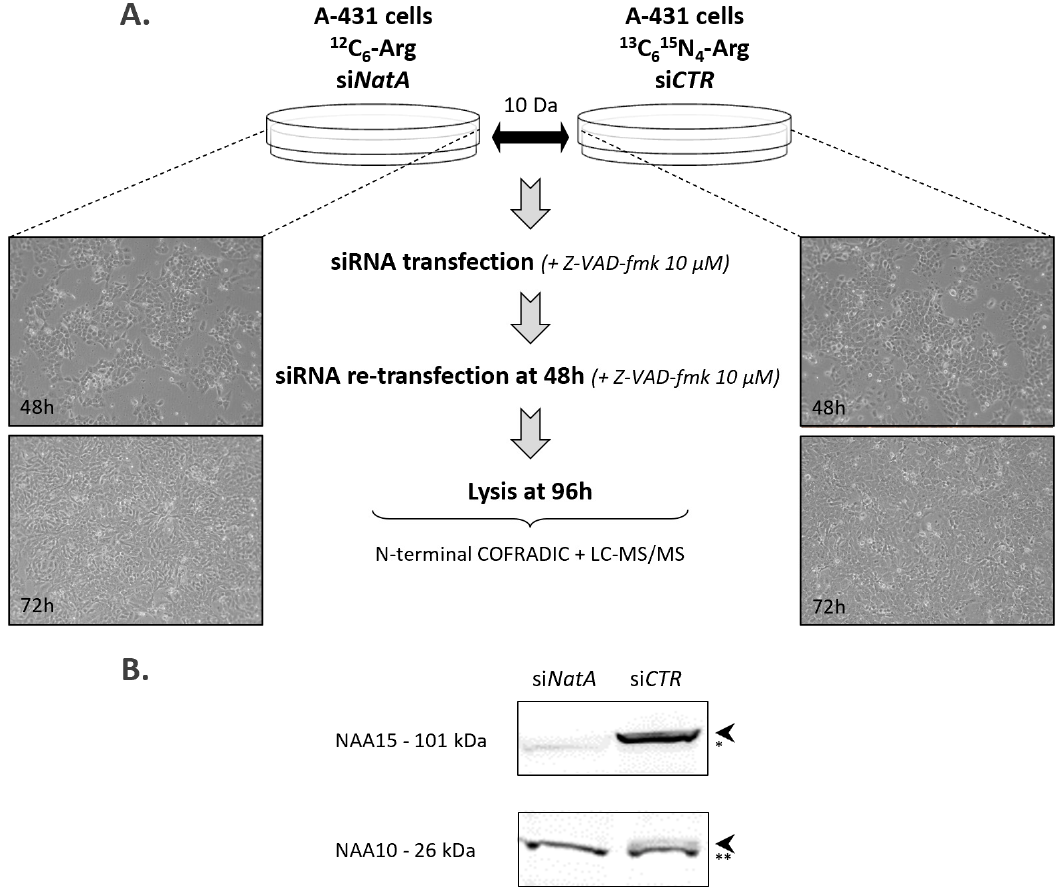
Figure 1. Experimental N-terminal proteomics workflow and confirmation of the efficiency of si NatA knockdown in human A-431 cells. ( A ) Workflow of the experimental setup used for N-terminal COFRADIC. A-431 cells cultivated in 13 C 615 N 4 L-arginine containing SILAC medium were transfected with 10 nM non-targeting siRNA (si CTR ) and cells cultivated in 12 C 6 L-arginine SILAC medium were transfected with 10 nM si NAA10 /si NAA15 pool (si NatA ). Knockdown was performed in the presence of the pan-caspase inhibitor Z-VAD-fmk (10 µ M). Cells were transfected 24 h after seeding, re-transfected under identical conditions 48 h after the initial transfection and harvested 96 h post initial siRNA transfection. ( B ) Immunoblots of A-431 cell lysates treated with non-targeting siRNA (si CTR ) or si NAA10 and si NAA15 (si NatA ). Blots were probed with anti-NAA10 and anti-NAA15 to assess levels of endogenous NAA10 (26 kDa) and NAA15 (101 kDa), thereby confirming highly efficient knockdown. The asterisks indicate non-specific bands with ** serving as loading